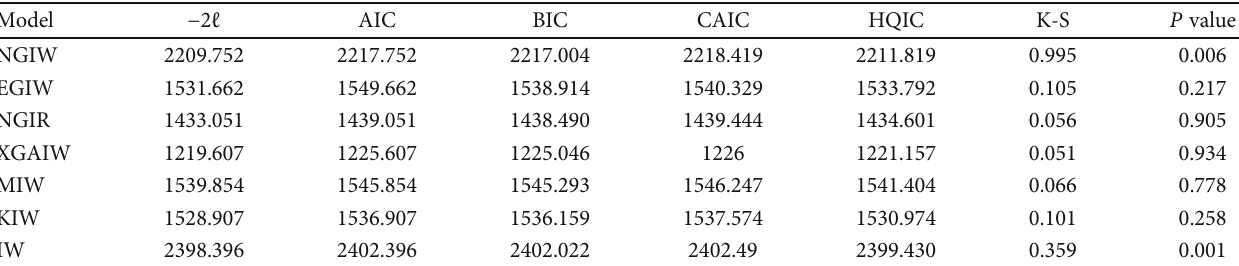
Table 8: Goodness-of- fi t measures for medical